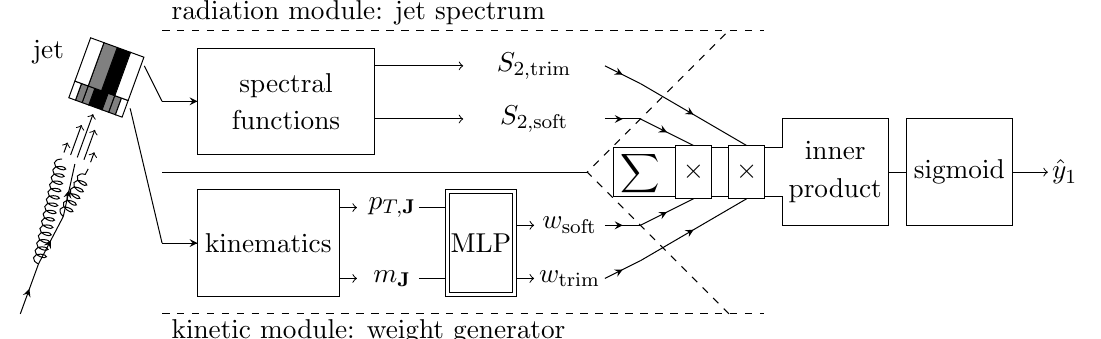
Figure 12 . A schematic diagram of a two-level architecture for binary classi(cid:12)cation. An MLP trained on p T; J and m J generates weights w trim and w soft for analyzing radiation patterns encoded in S 2 ; trim and S 2 ; soft spectra. Double bordered boxes represent trainable modules. The ^ y 2 is given by the normalization, i.e., ^ y 2 = 1 ^ y 1 (cid:0)